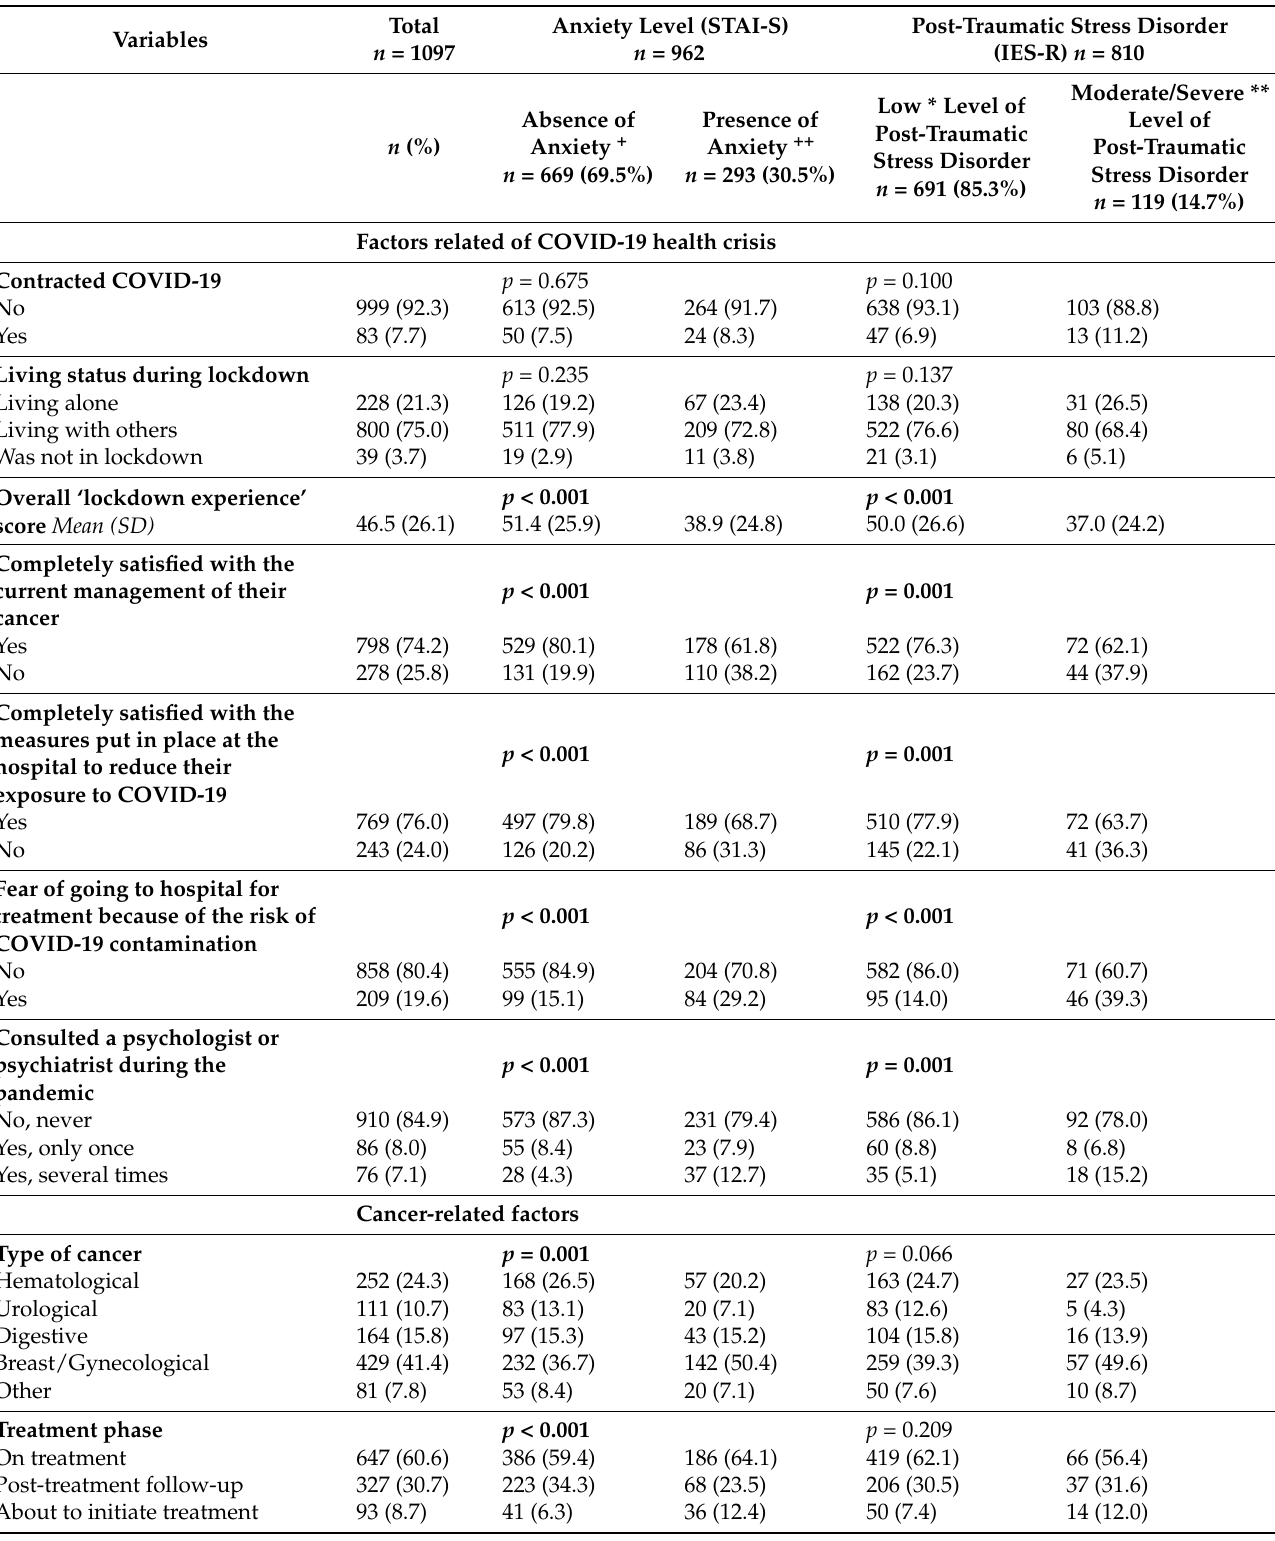
Table 1. Characteristics of the participants and factors associated with anxiety level and post- traumatic stress disorder during the COVID-19 health crisis: univariate